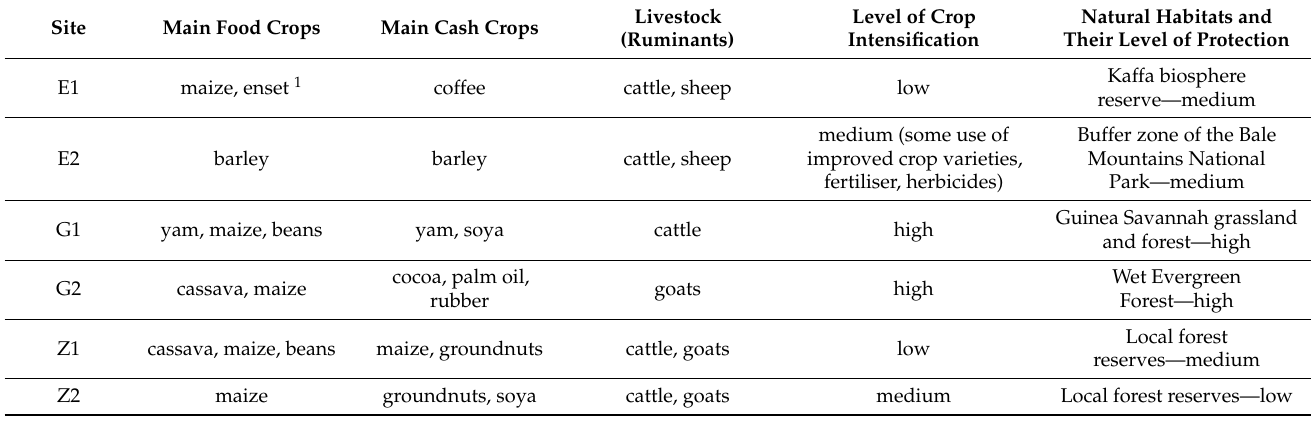
Figure 1. Location of the research sites (map by Vemaps.com) in Ethiopia, Ghana, and Zambia, respectively. Table 1. Main characteristics of the research sites.